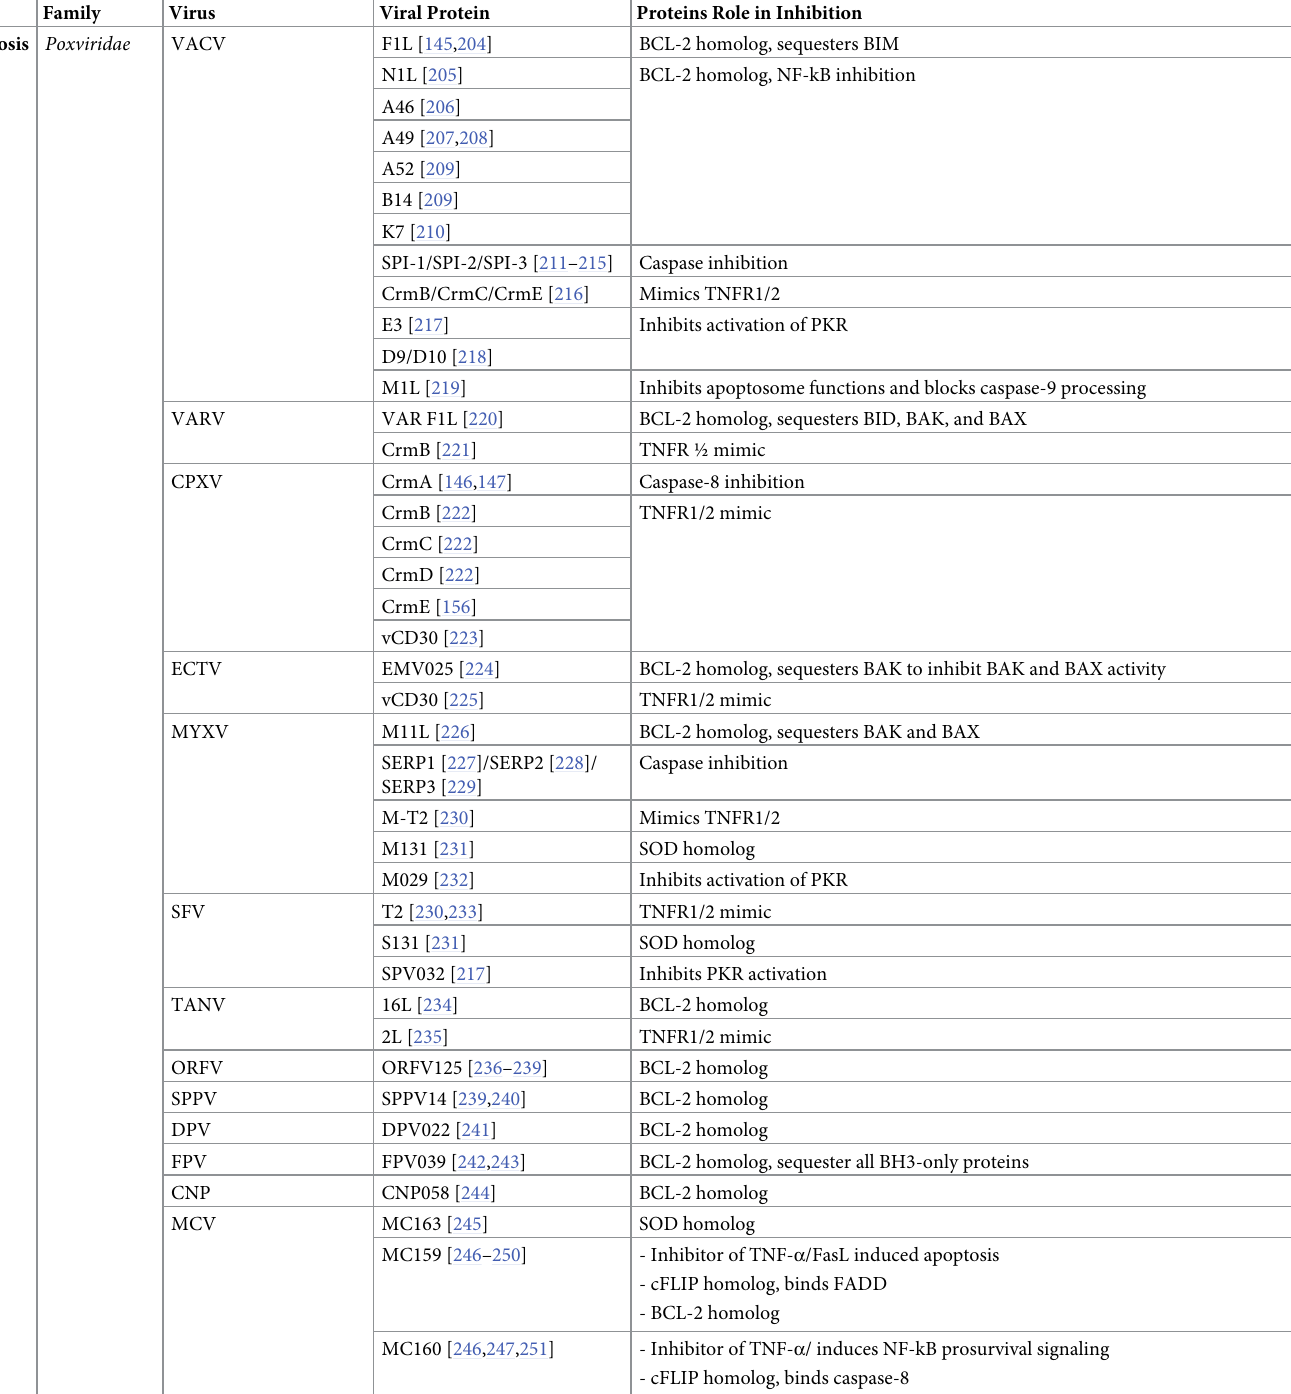
Table 1. Mechanisms of apoptosis inhibition by